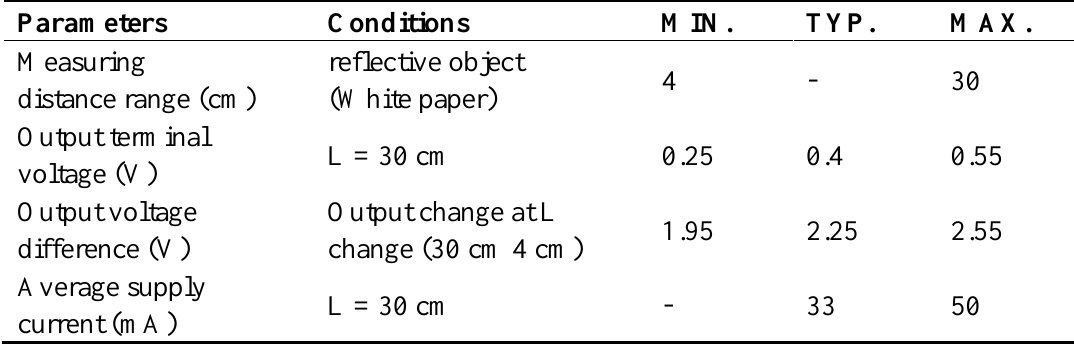
Table 1. Electro-optical characteristics.